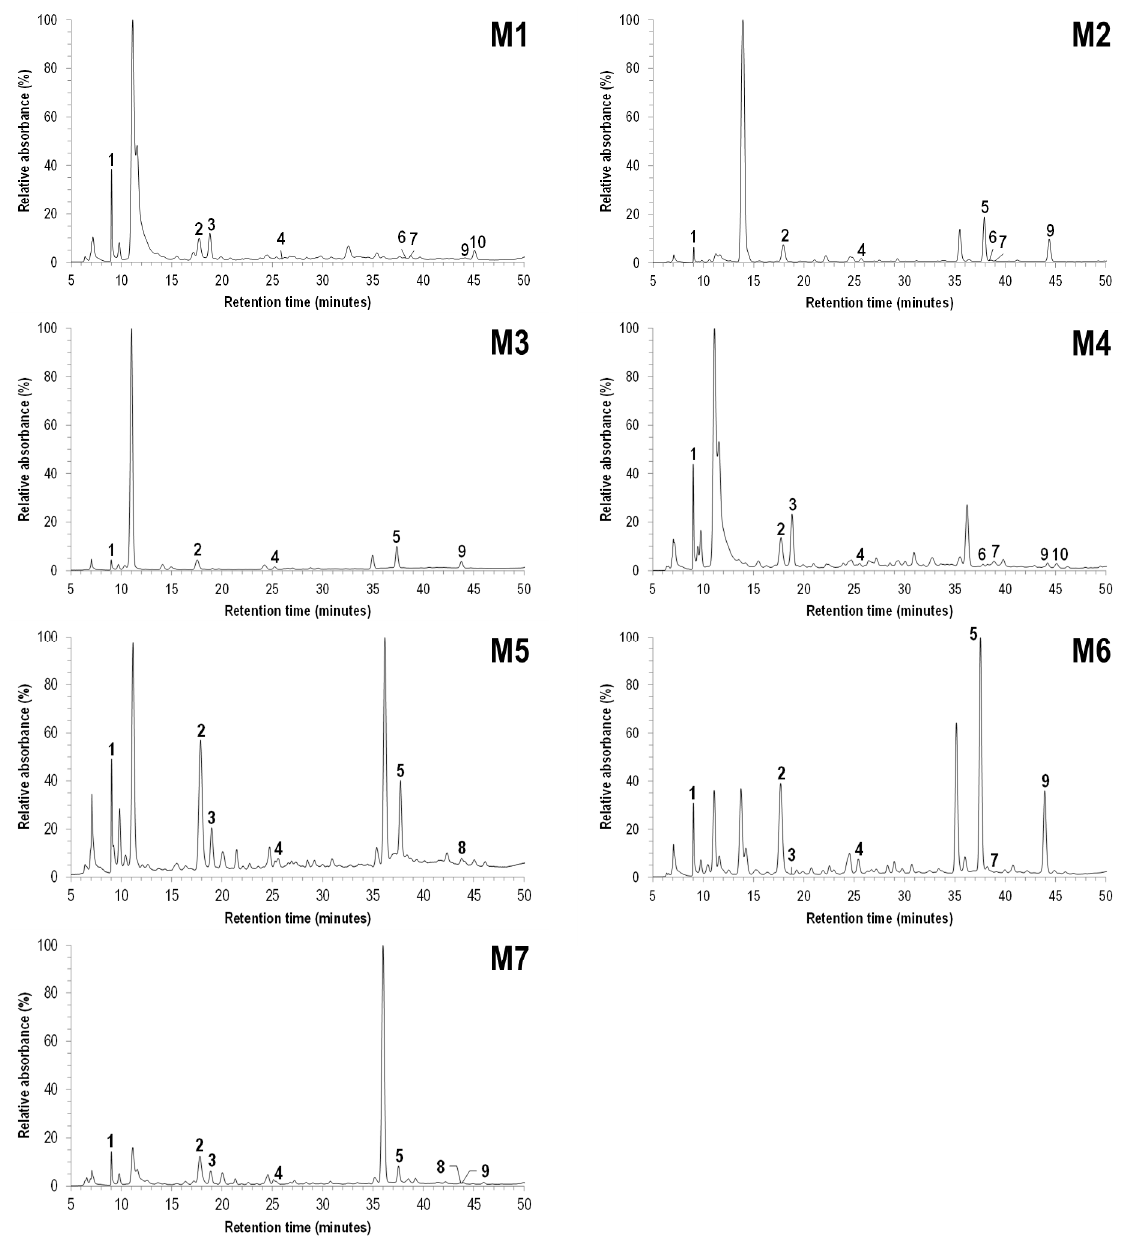
Figure 2. LC/DAD chromatographic profiles of the studied honey extracts, recorded at 270 nm. Peak identification in Table 6.